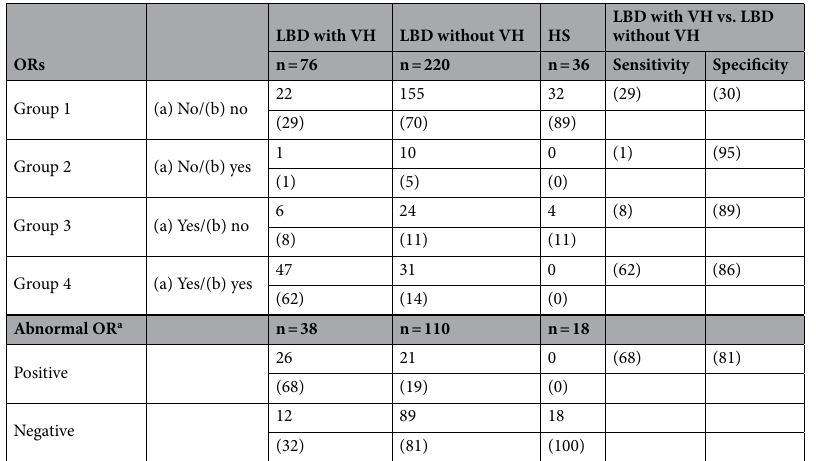
Table 2. Blinded evaluation in radiologist 1. Data are raw data; numbers in parentheses are the percentages. LBD Lewy’s body disease, VH visual hallucination, HS healthy subject(s), OR optic radiation. a The abnormal OR positive group (the abnormal OR on at least one side) or abnormal OR negative group (the abnormal OR on both bilateral sides).